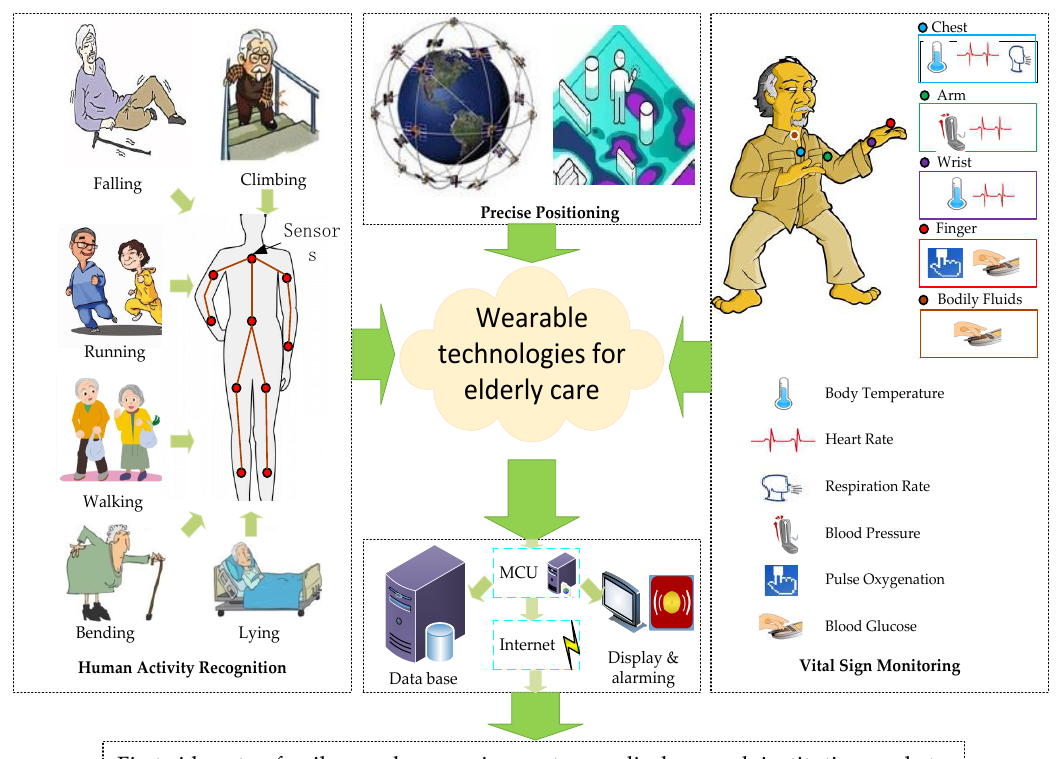
Figure 1. Schematic of functions for elderly care, including precise indoor positioning, physical activity tracking and real-time monitoring of vital signs.